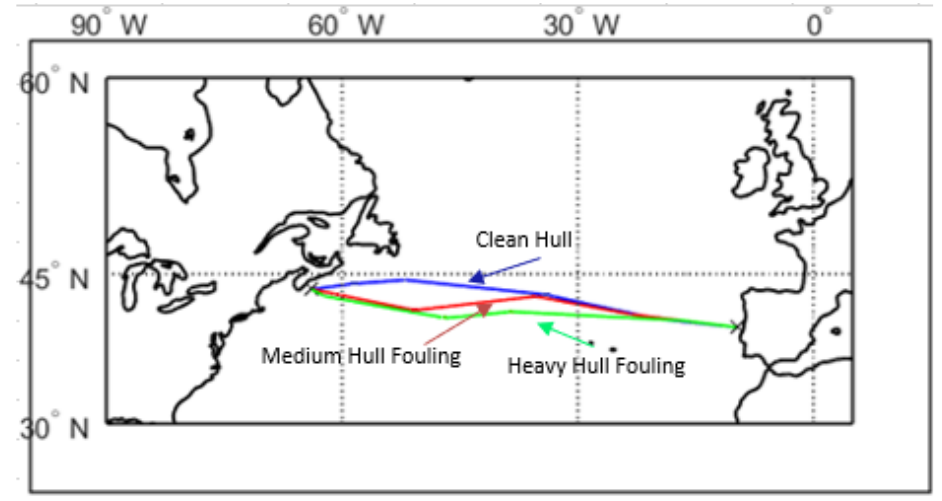
Figure 7. Optimal routes with a constant speed of 18 kn for Cases 1 (clean hull), 2 (medium hull fouling), and 3 (heave hull fouling).